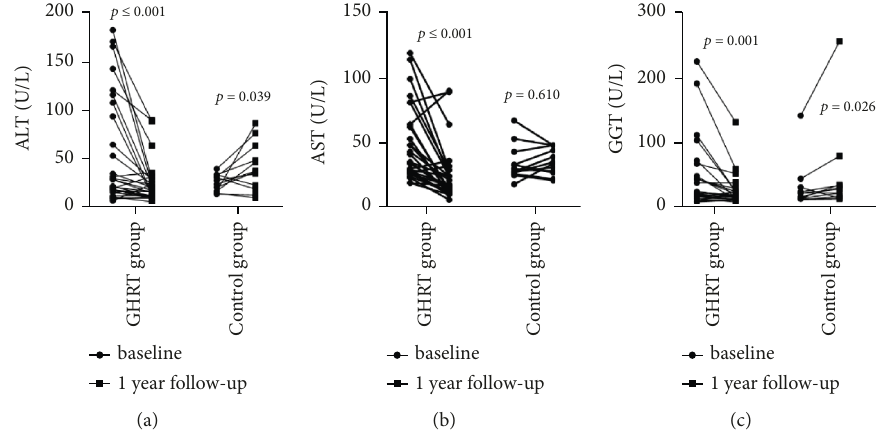
Figure 3: Decreased transaminase activity after one-year treatment with